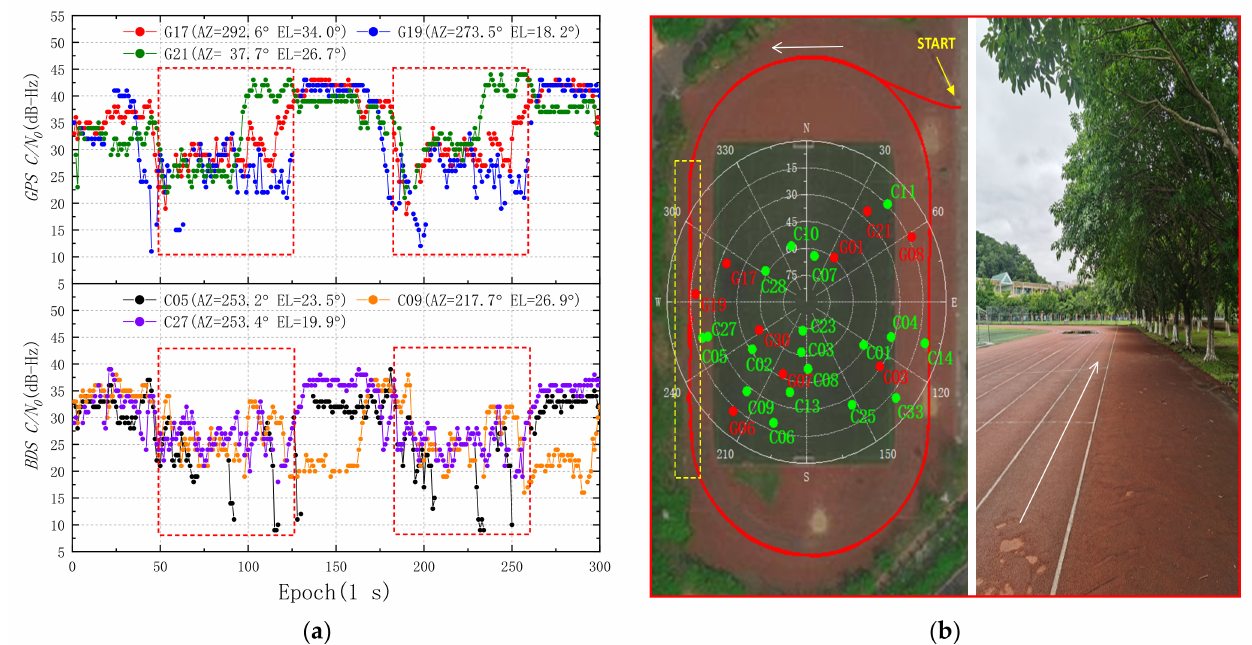
Figure 4. Carrier-to-noise power density ratio values of GNSS satellites observed by the Huawei Mate 30 on the playground. ( a ) Some GPS and BDS satellites whose signals are degraded due to the trees, and the red box shows the C/N 0 value in the area marked by the yellow box in Figure 4b. ( b ) Left: reference trajectory and sky plot of GPS and BDS. Right: realistic environment marked by the yellow